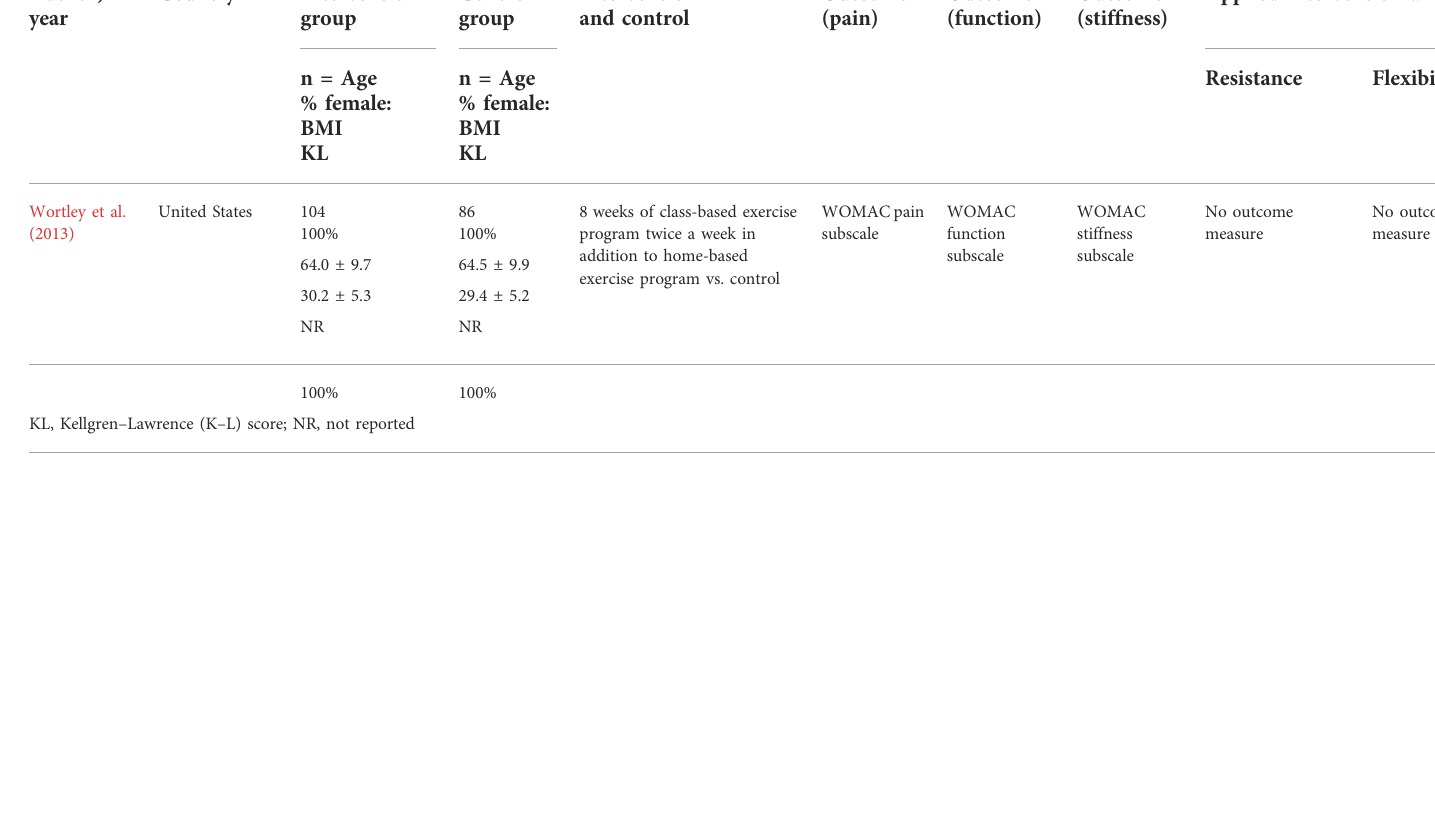
Outcome Outcome Outcome Applied intervention and relevant measure (pain) (function) (stiffness) Resistance Flexibility Cardiorespiratory